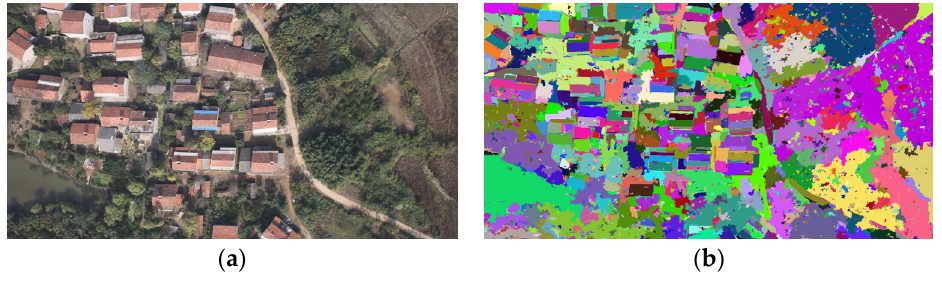
Figure 4. Image Segmentation Result. ( a ) Original image ( b ) Segmented image.